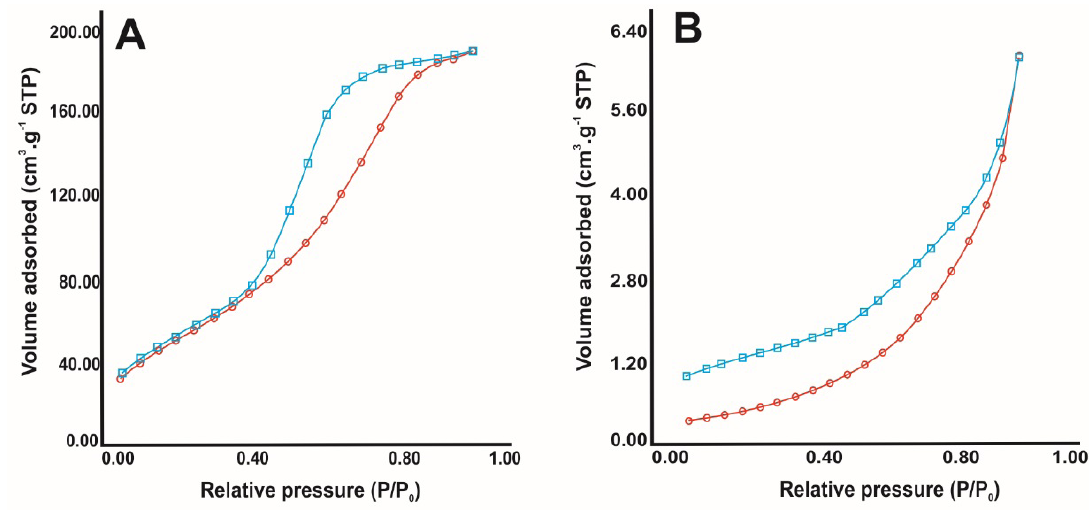
isotherms of adsorption (○) and desorption (□): (A) A-mbmim[Tf Figure 4. N 2